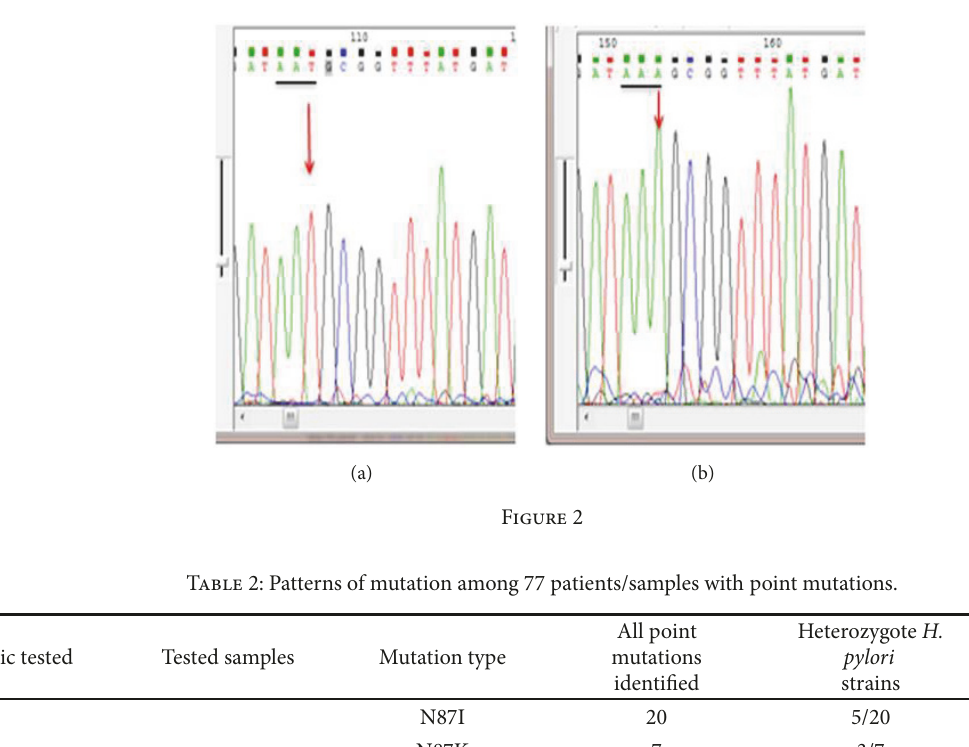
Antibiotic tested Tested samples Mutation type